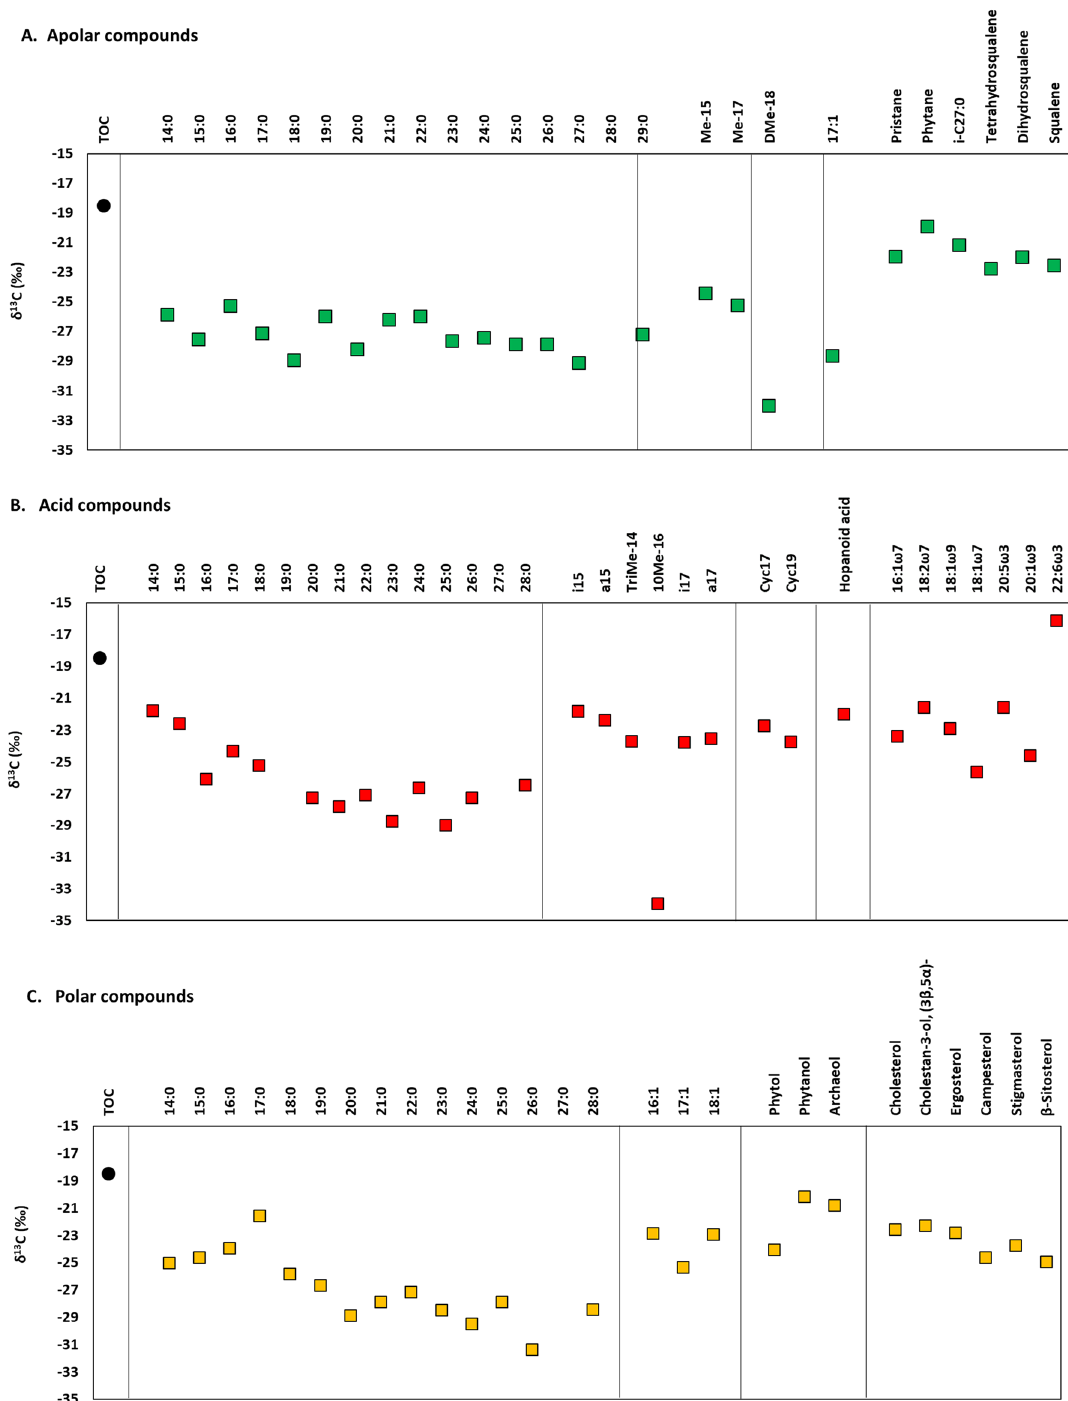
Figure 4. Compound-specific isotopic composition (δ 13 C) of the lipid compounds identified in Tirez in analyses carried out in 2021, in the three polarity fractions; ( A ) apolar, ( B ) acid, and ( C ) polar. The isotopic composition of the total biomass (δ 13 C TOC ) is shown in each fraction for